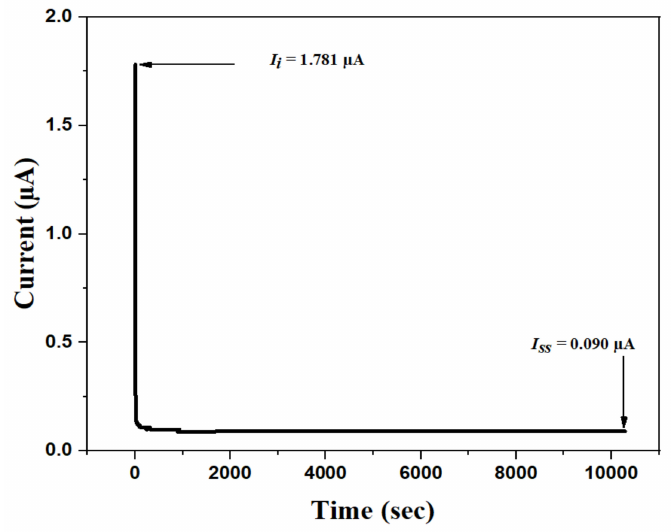
Figure 11. TNM plot of MPKE15